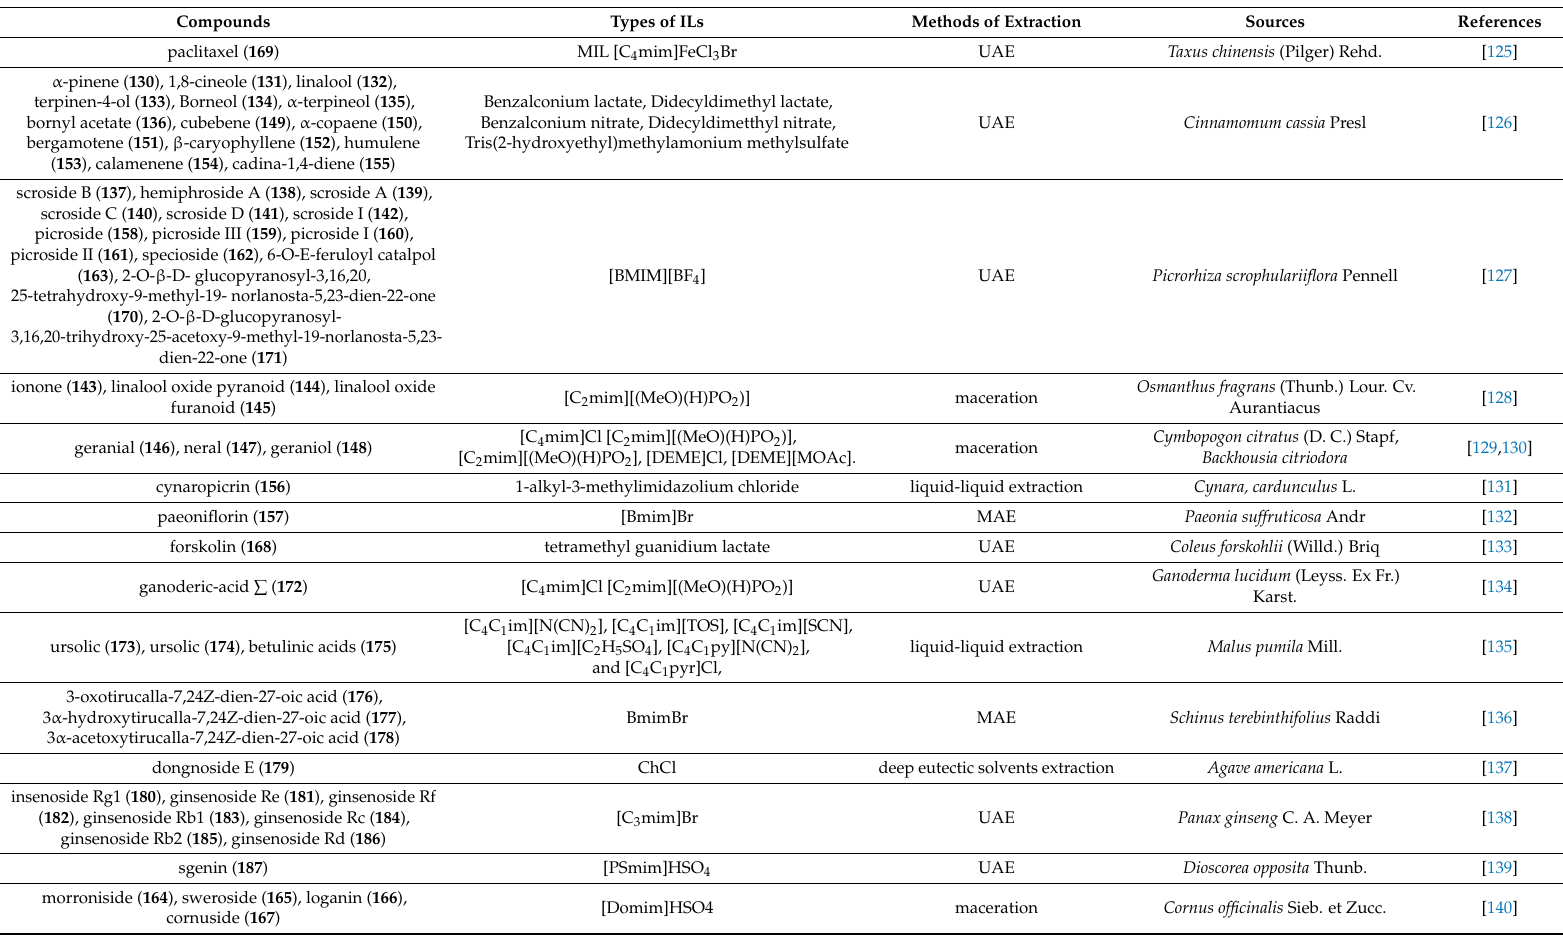
Table 6. The terpenoids extracted from natural sources using ILs or IL solutions by different extraction